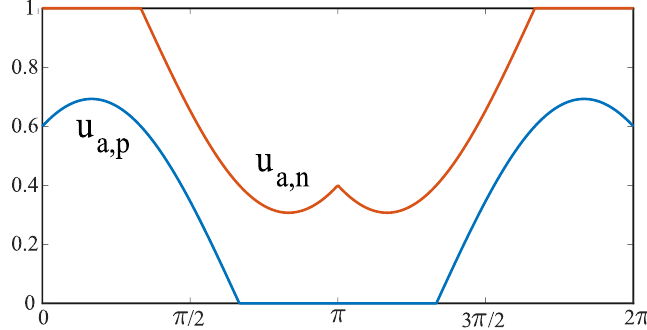
Figure 5. Positive and negative modulation waves of phase A, m = 0.8.